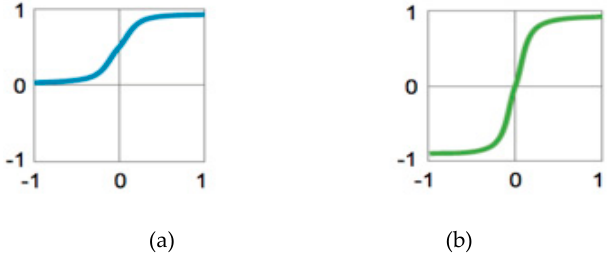
Figure 22. Activation function: ( a ) Sigmoid function, and ( b ) hyperbolic transient.